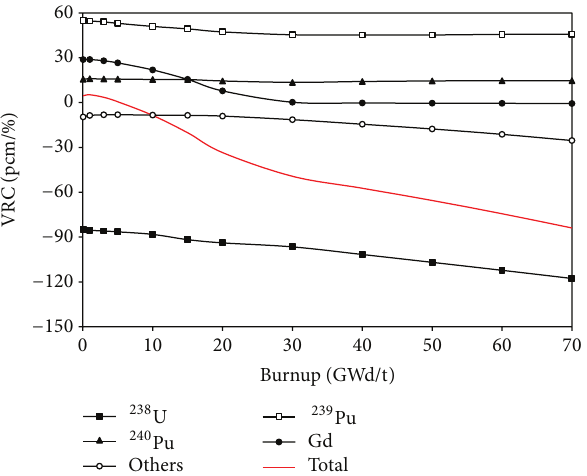
Figure 4: Void reactivity coefficient varying during burnup for innovative assemblies’ designs.